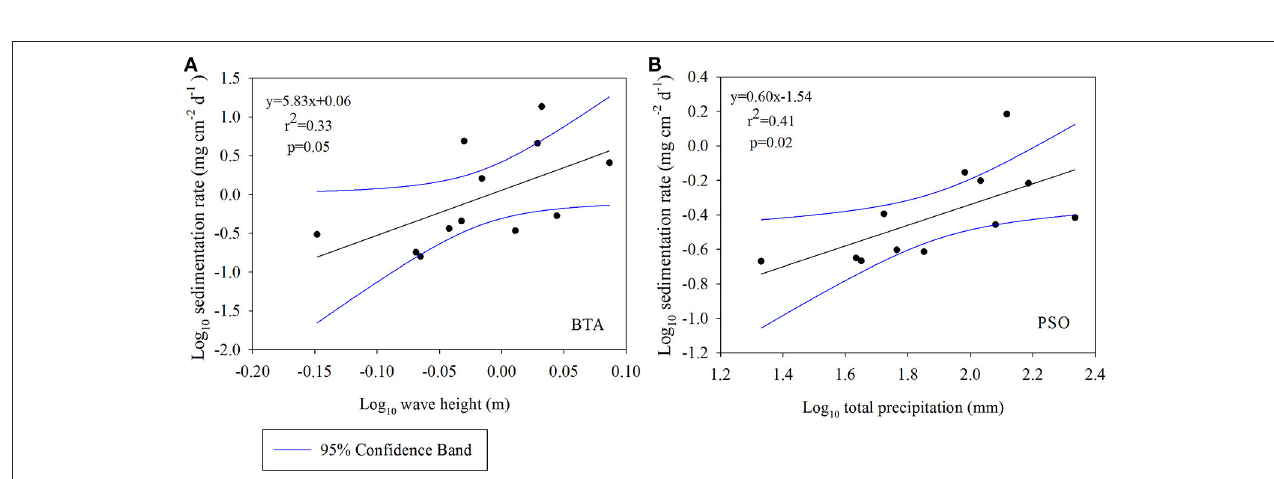
FIGURE 10 | Linear regression of sedimentation rate with total precipitation at BTA (A) and PSO (B) . Blue line is 95% confidence interval band.